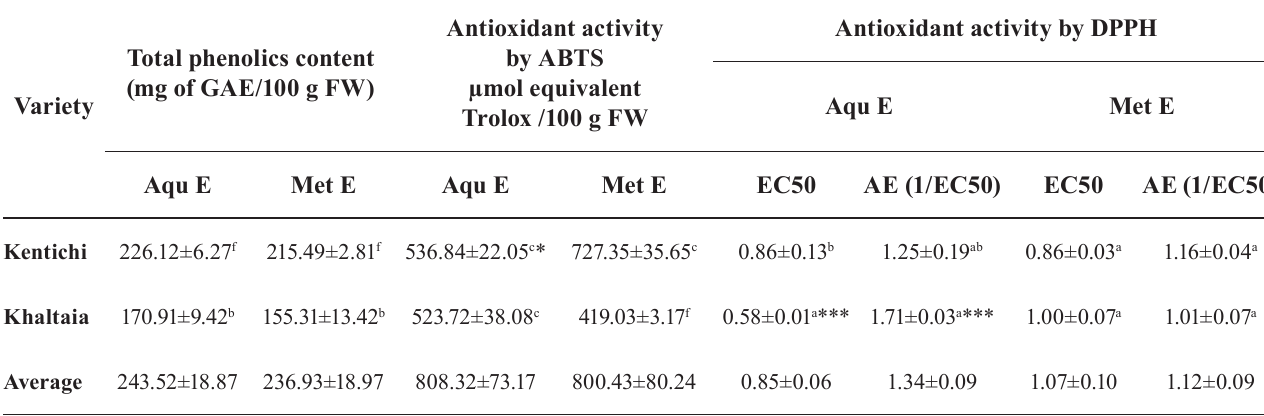
TABLE VI - Total phenolic content and antioxidant activity of date palm fruit varieties at the Tamar stage, grown in Tunisia Antioxidant activity Antioxidant activity by DPPH Total phenolics content by ABTS (mg of GAE/100 g FW) µmol equivalent Aqu E Met E Variety Trolox /100 g FW Aqu E Met E Aqu E Met E EC50 AE (1/EC50) EC50 AE (1/EC50) Kentichi 226.12±6.27 f 215.49±2.81 f 536.84±22.05 c * 727.35±35.65 c 0.86±0.13 b 1.25±0.19 ab 0.86±0.03 a 1.16±0.04 a Khaltaia 170.91±9.42 b 155.31±13.42 b 523.72±38.08 c 419.03±3.17 f 0.58±0.01 a *** 1.71±0.03 a *** 1.00±0.07 a 1.01±0.07 a Average 243.52±18.87 236.93±18.97 808.32±73.17 800.43±80.24 0.85±0.06 1.34±0.09 1.07±0.10 1.12±0.09 Data are expressed as mean ± SD (n=3) on a fresh weight basis. Means in the same column with different superscript differ significantly ( p